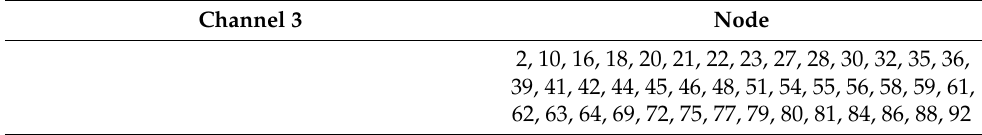
Figure 10. Channel 3 grouping. Table 8 is a node that enters the channel group 3. Table 8 . Node channel 3. Table 8. Node channel 3.